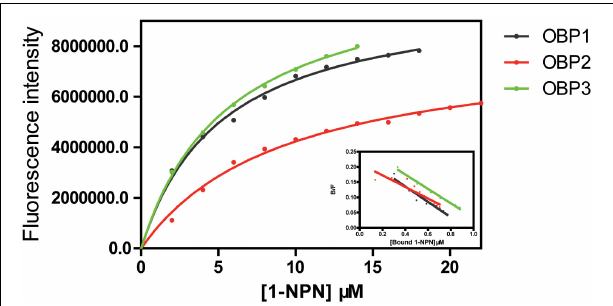
FIGURE 5 | Competitive fluorescence binding of Trissolcus japonicus OBPs and 1-NPN.